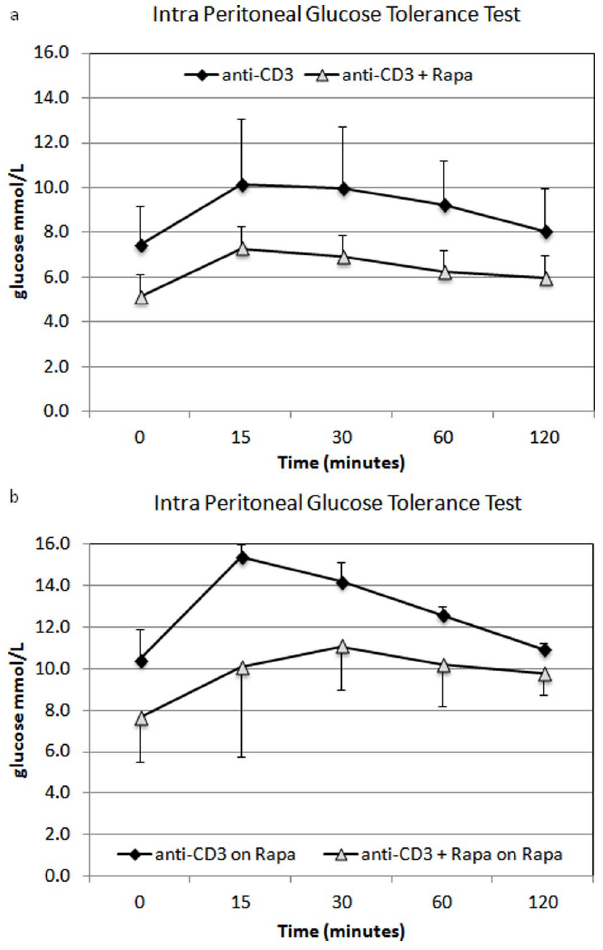
Figure 2. Intraperitoneal glucose tolerance test performed on fasted mice after completion of treatment course (day 17–20). (A) Mice who received anti-CD3 alone (N=6) or followed by 14 days of rapamycin (N=7) were injected IP with 2 grams/kg glucose solution and sampled for blood glucose levels. (B) Mice from both groups, anti- Figure 1. Anti-CD3 + rapamycin vs. anti-CD3 monotherapy in CD3 alone (N=3) or in combination with rapamycin (N=5) were N diabetic NOD mice. Diabetic NOD mice were treated with either a challenged with rapamycin 1 mg/kg for two consecutive days. Glucose ) or a singleinjection of single injection of 50 m g anti-CD3 alone ( levels during an IPGTT done on day 3. 50 m g anti-CD3 followed by 14 days of intraperitoneal rapamycin 1 mg/